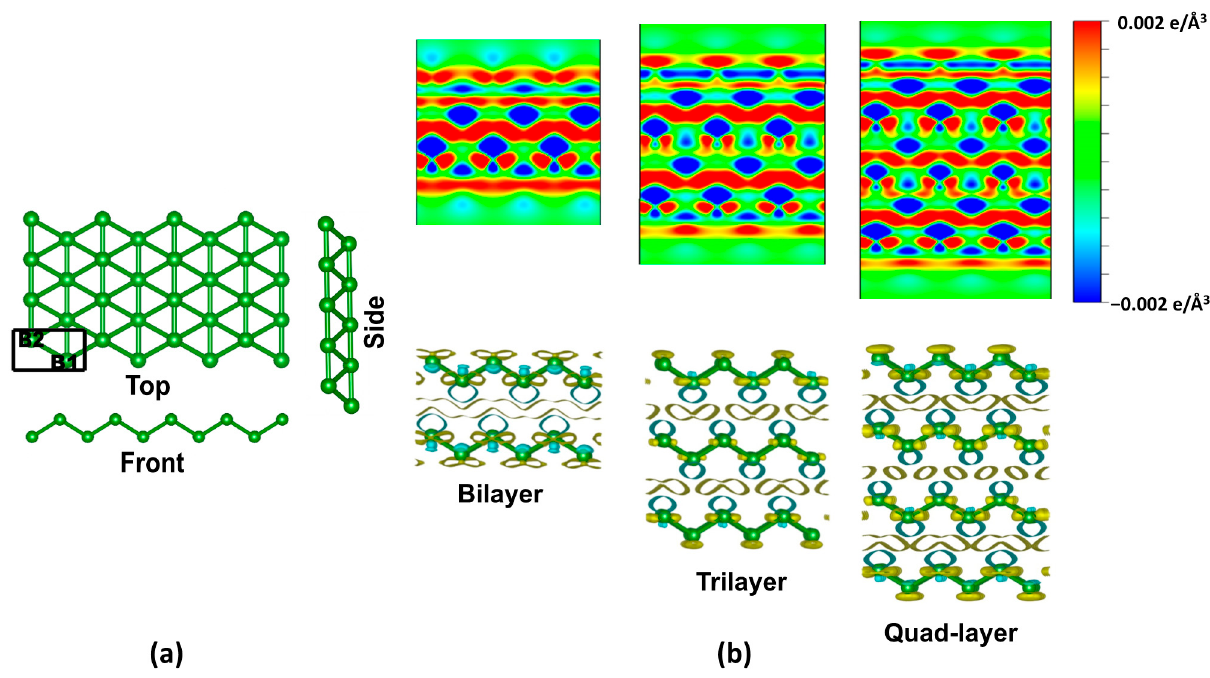
Figure 1. ( a ) The top, side, and front views of monolayer borophene. The atoms occupying the B1 and B2 sites are on different planes. A rectangular box represents the unit cell. ( b ) The 2D cross-sectional display of the charge density difference plot along the xz direction for the bilayer, trilayer, and quad-layer of borophene. The iso-value for the electron density is 0.002 e/Å 3 . The yellow (cyan) represents charge accumulation (depletion).